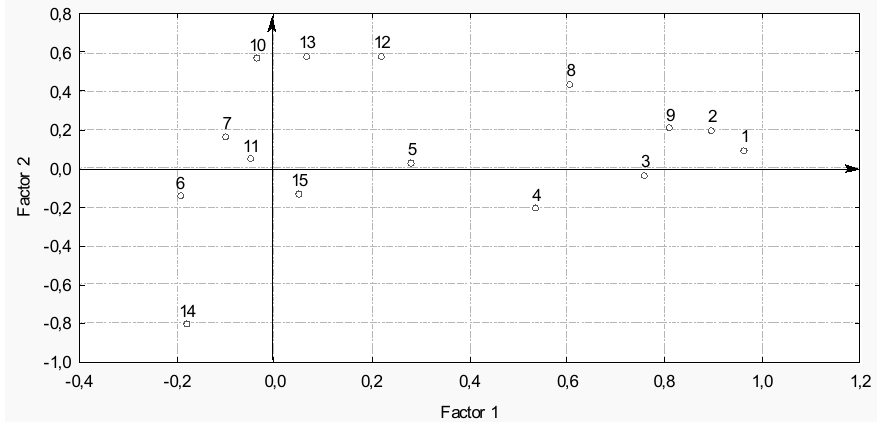
Fig. 2. Variables in the plane of the 1 st and 2 nd